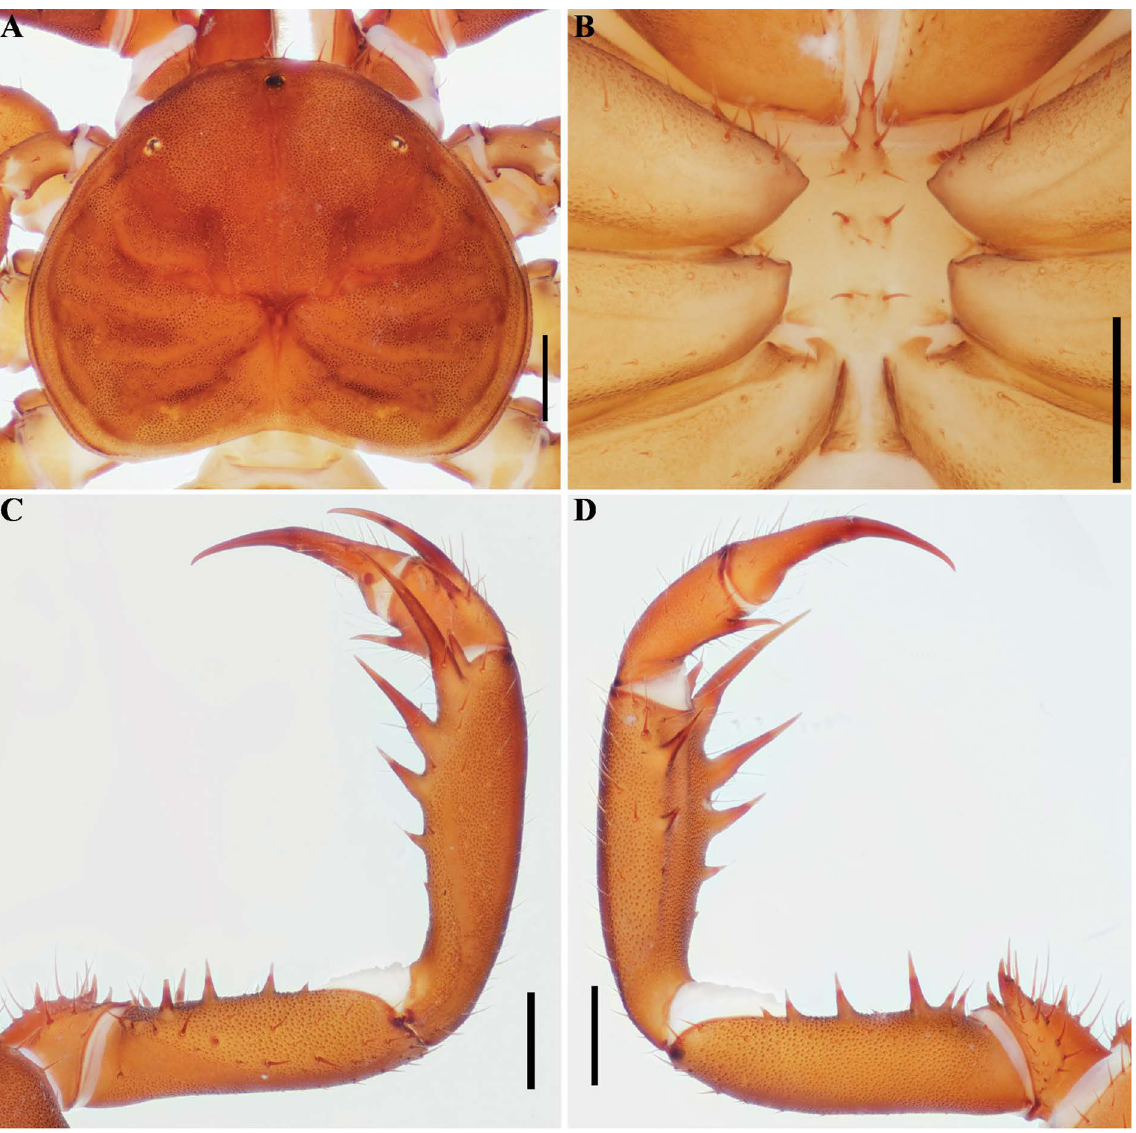
Fig. 36. Charinus insularis Banks, 1902 (RBINS), general morphology, ♀. A . Carapace, dorsal view. B . Sternum, ventral view. C . Pedipalp, dorsal view. D . Pedipalp, ventral view. Scale bars: 1